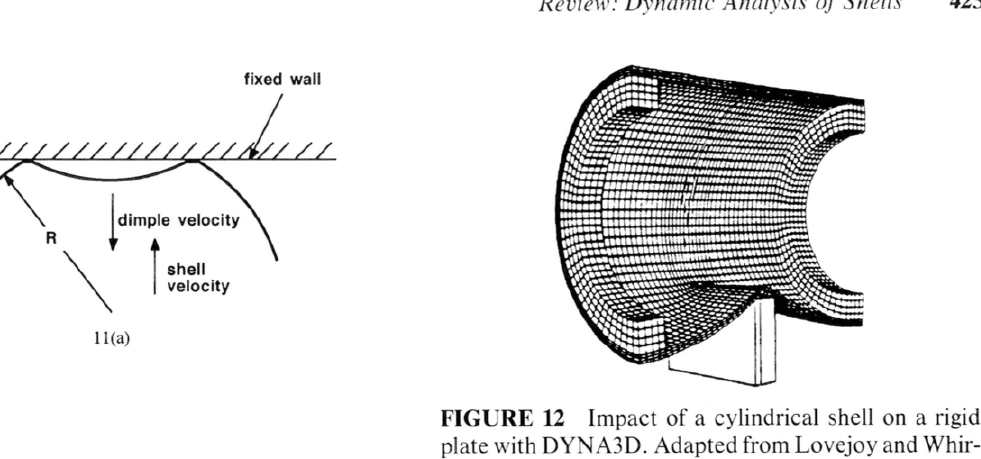
FIGURE 12 Impact of a cylindrical shell on a rigid plate with DYNA3D. Adapted from Lovejoy and Whir ley (1990).